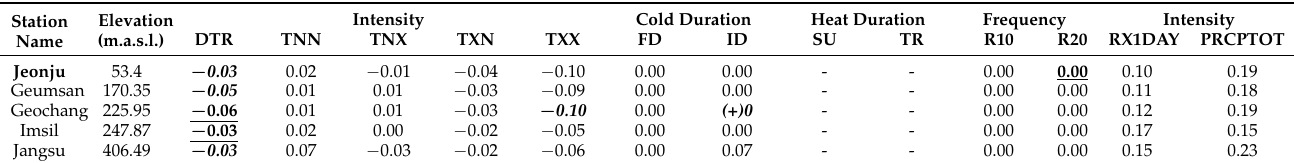
Table A18. Trend magnitudes for the month of December in the UGRB for 33 years